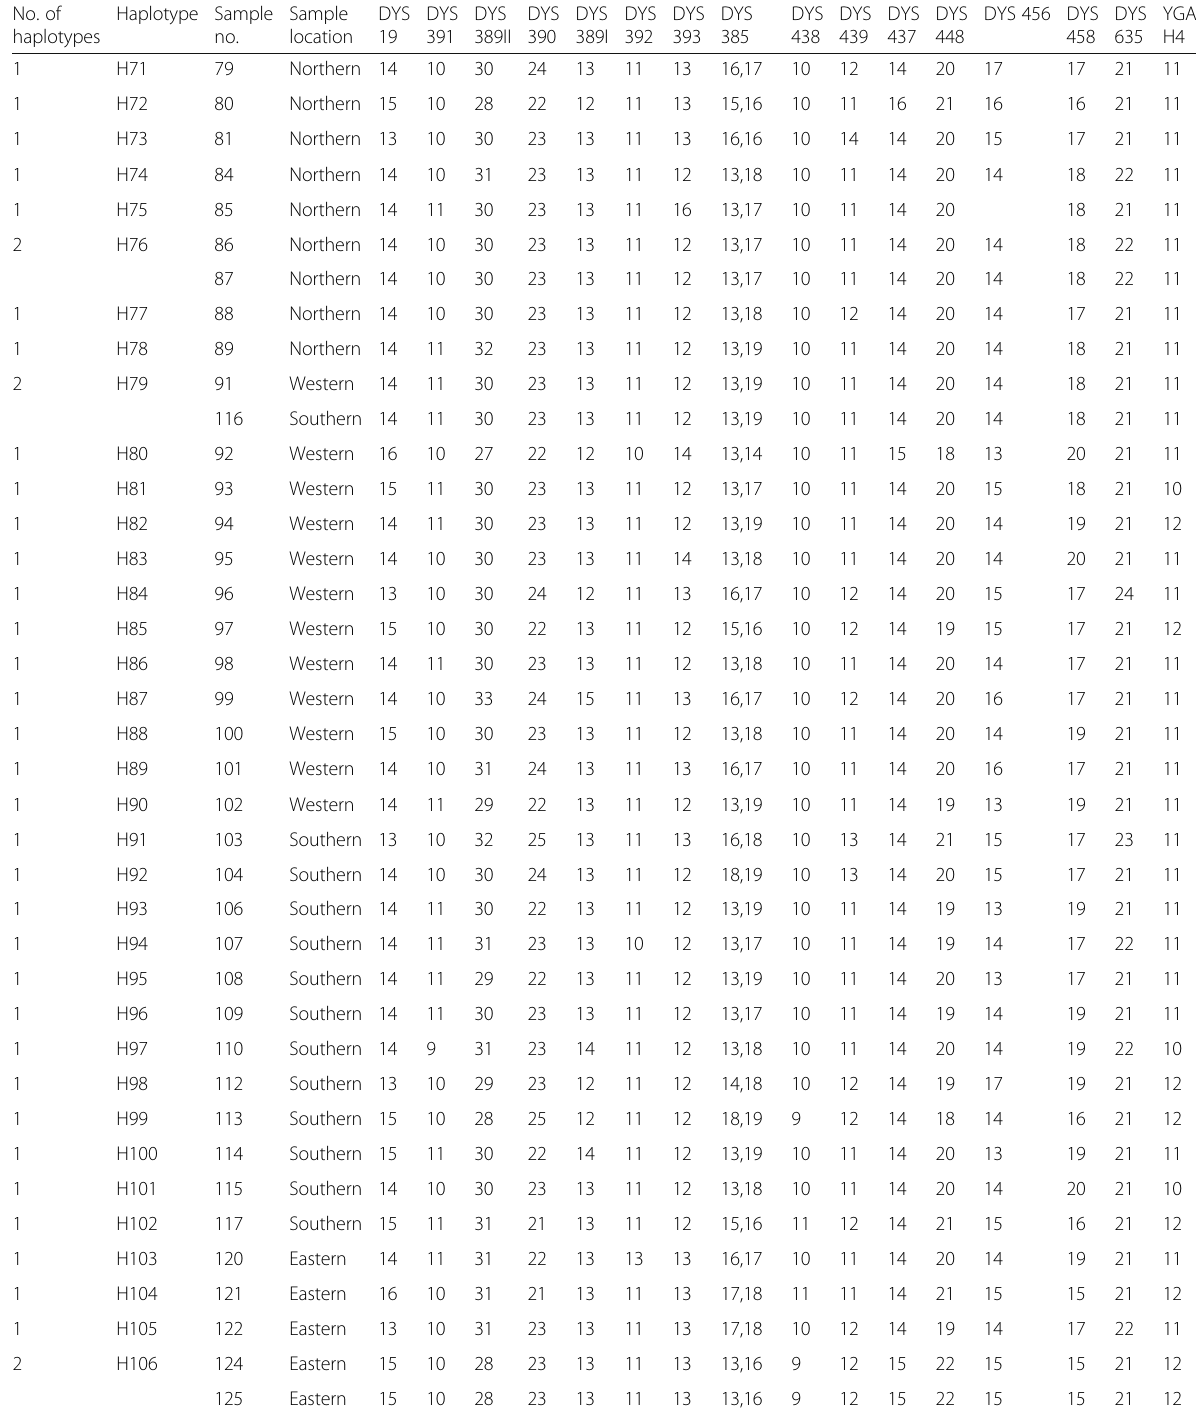
Table 2 Y chromosome haplotype analysis of 17-YSTR markers in male Saudi population ( n = 125) (Continued) No. of Haplotype Sample haplotypes